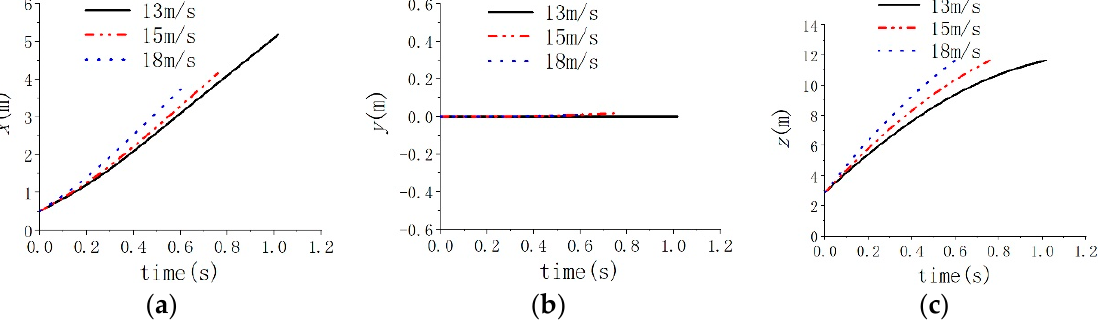
Figure 16. Centroid coordinates of vehicle in case 3, 6, 9. ( a ) Vehicle centroid X -axis coordinates. ( b ) Vehicle centroid Y -axis Coordinates. ( c ) Vehicle centroid Z -axis coordinates.